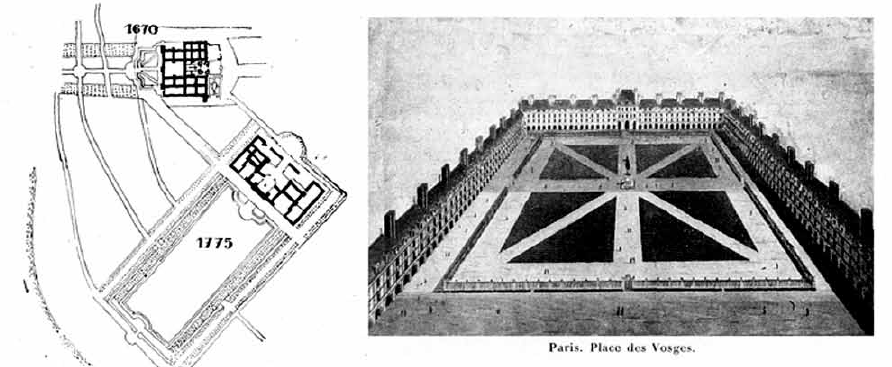
flC-aDaGPfig. 21. Images of Hôtel des Invalides, l’Ecole Militaire and the Place les Vosgues in Urbanisme . ©